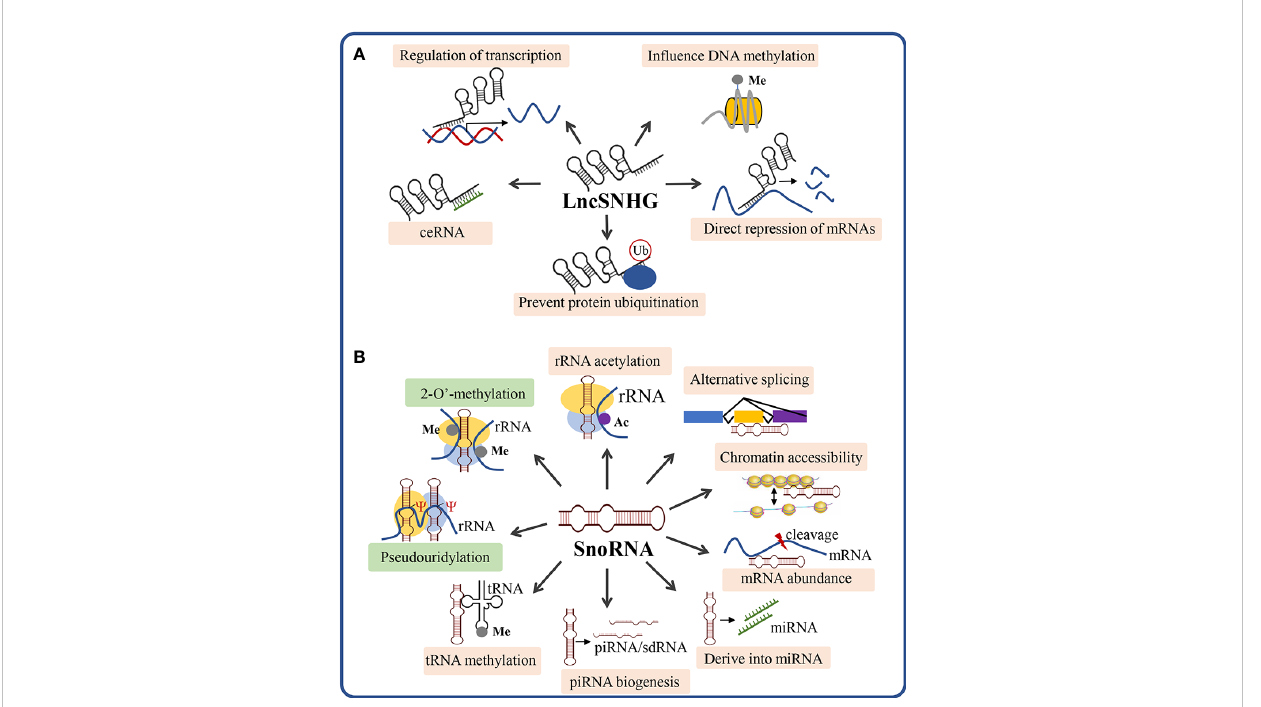
FIGURE 2 Scheme of the mechanism of action of lncSNHG and snoRNA. (A) The 5 most studied mechanism of lncSNHGs to exert their regulatory functions. Ub, ubiquitination; Me, methyl. (B) The canonical and non-canonical mechanisms underlying snoRNA-mediated bioactivities. Green boxes show the canonical mechanisms of snoRNA to regulate the biosynthesis and modi fi cation of rRNA, tRNA, and snRNA. The orange boxes show the non- canonical mechanisms of snoRNA. Ac, acetyl; Me, methyl; Y , pseudouridylic